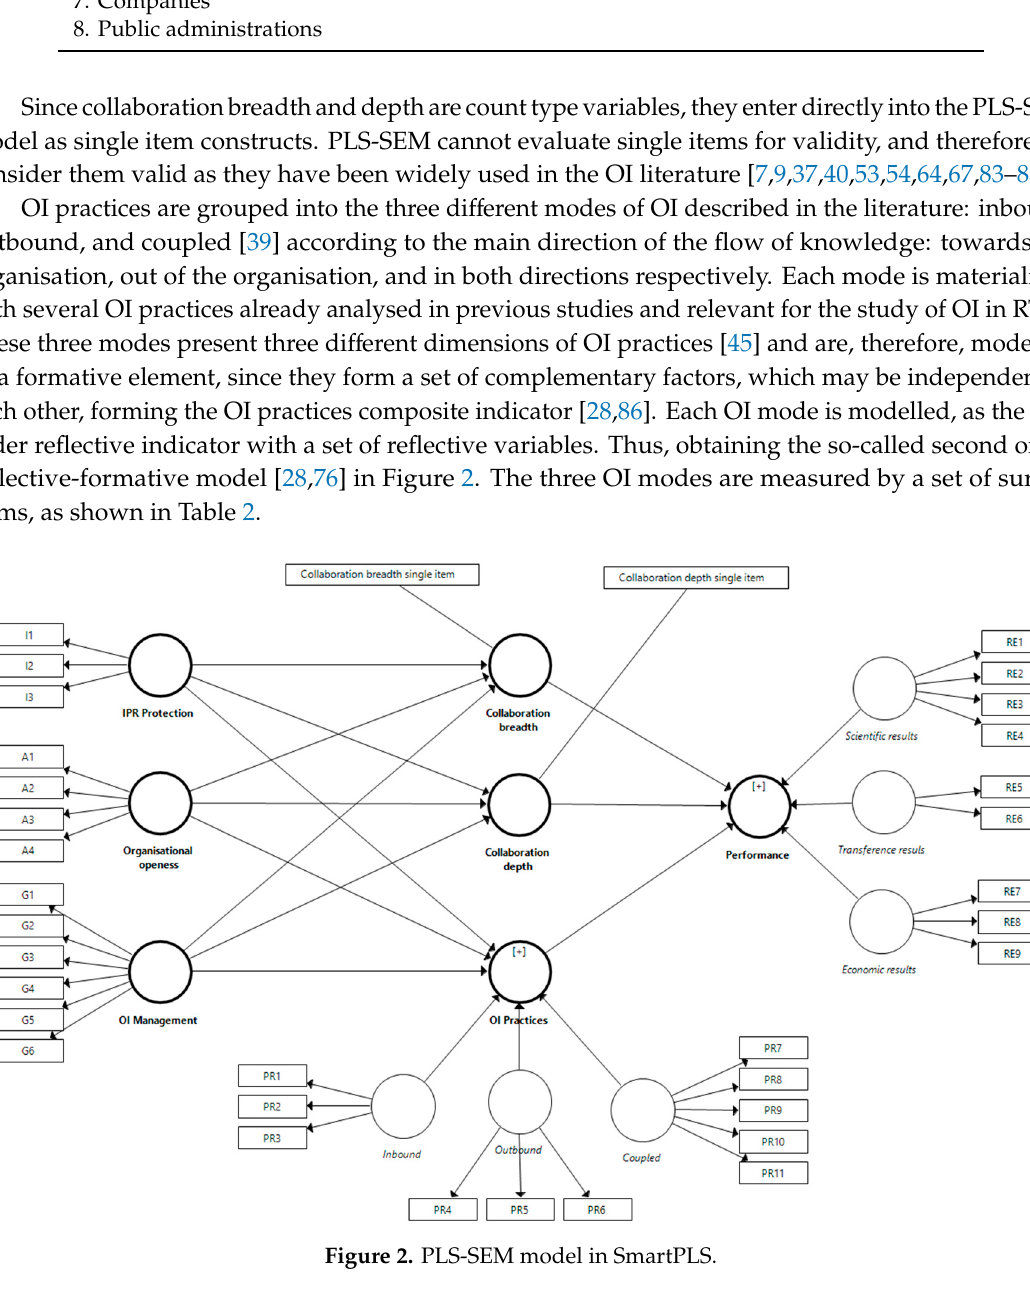
Table 4. Performance survey questions.